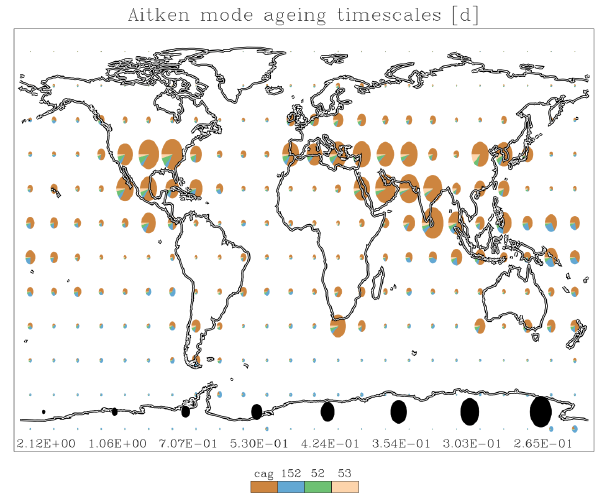
Figure 10. Aging timescales of the hydrophobic Aitken mode. This (cid:16) ∂N (cid:17) timescale is defined as N/ , with N the number density and ∂t ∂N its time derivative due to aging processes only. The colors in- ∂t dicate processes (Table 2), the radius of the pie indicates the aging timescale (inverse linear